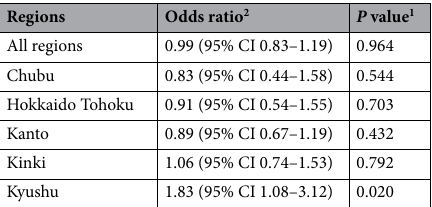
Table 4. Odds ratio between genders of undergoing surgery within 1 week of onset and the results of statistical test. 1 Fisher’s Exact Test for Count Data with simulated P value. 2 CI: confidence interval.